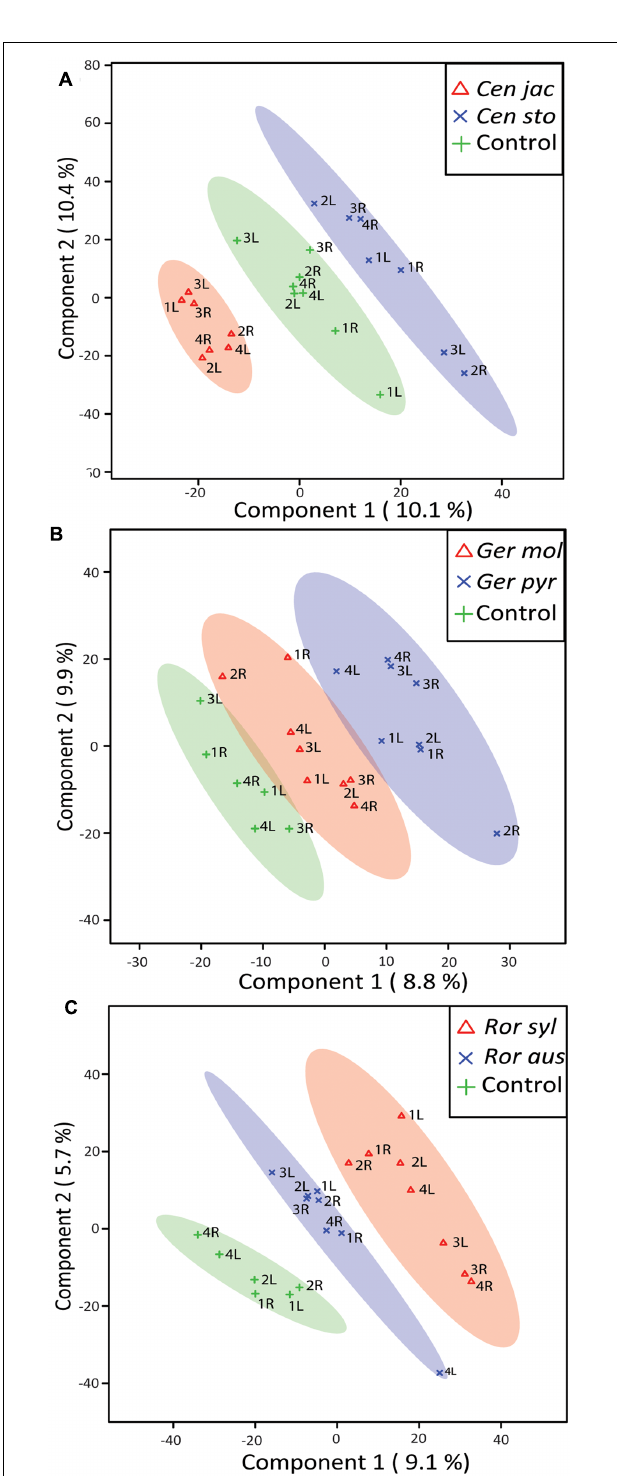
FIGURE 4 | Partial least square-discriminant analysis (PLS-DA) score plots of root volatile profiles measured with GC-QTOF-MS. The semi-transparent ovals outline the 95% confidence intervals of natives (red triangles), range-expanders (blue crosses) and sterilized control soils (green crosses) for Centaurea (A) , Geranium (B) , and Rorippa (C) . Sample numbers and position of the volatile trap (left or right) are